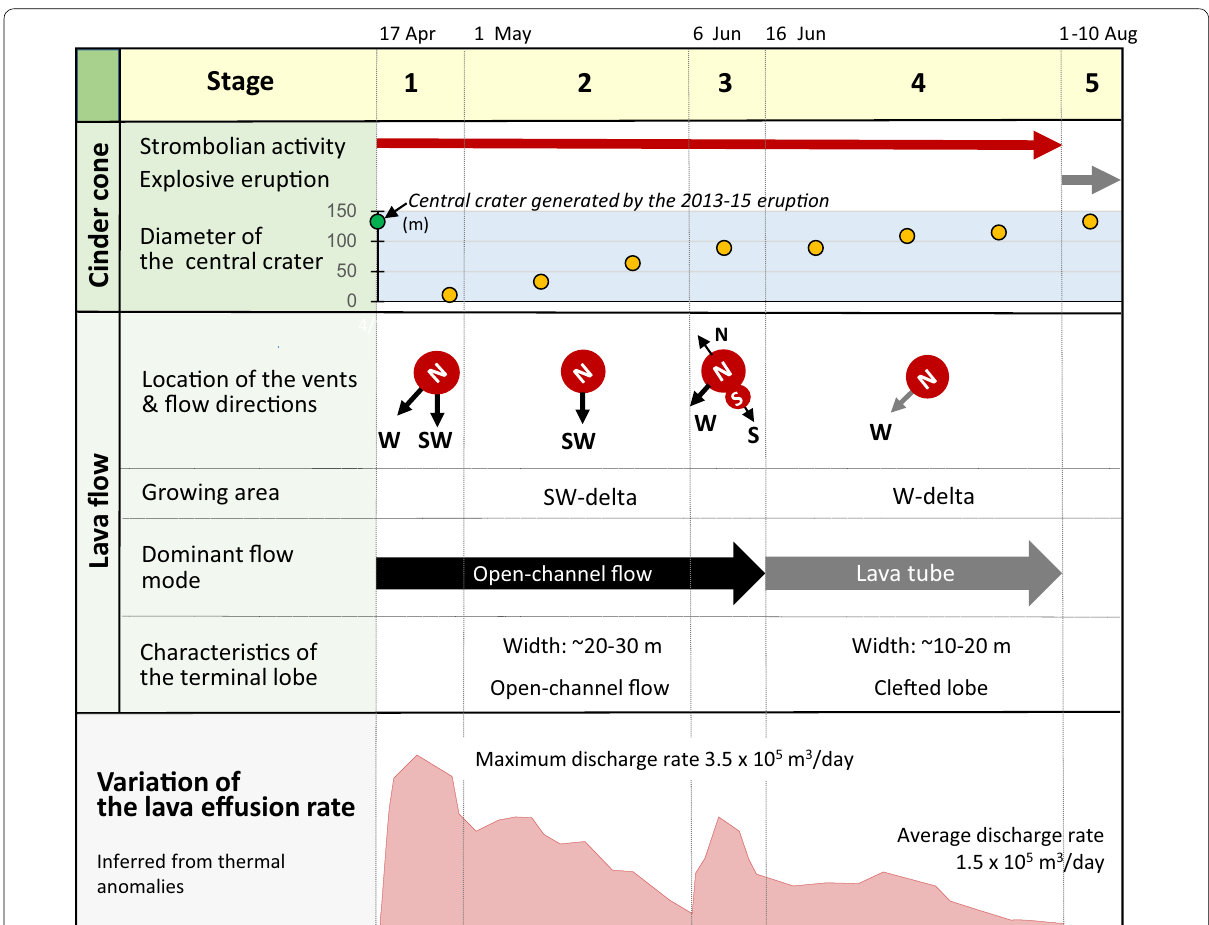
Fig. 9 Summary of the eruption sequence for the 2017 Nishinoshima eruption based on the analysis of high-frequency infrared images from the Himawari-8 AHI and high-spatial-resolution images from ALOS-2, Landsat-8, and